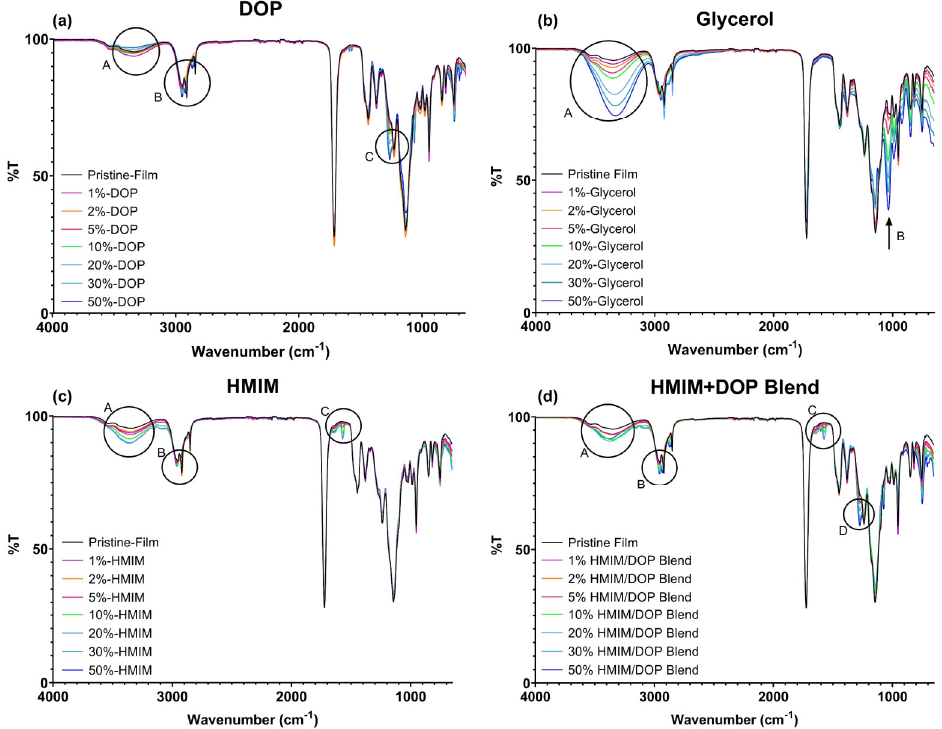
Figure 3. FTIR Spectra of ( a ) DOP, ( b ) Glycerol, ( c ) HMIM and ( d ) HMIM and DOP blend plasticized samples with varying concentrations.